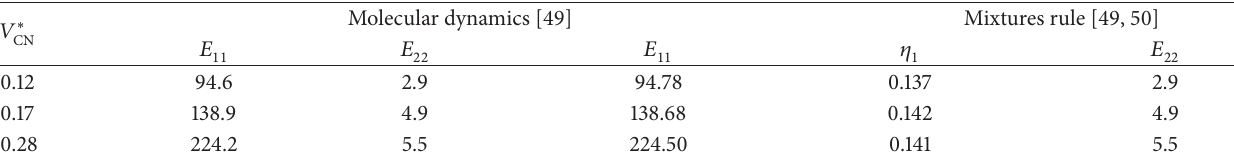
Table 2: Young’s moduli for the composite PMMA/CNT: mixtures rule in comparison with molecular